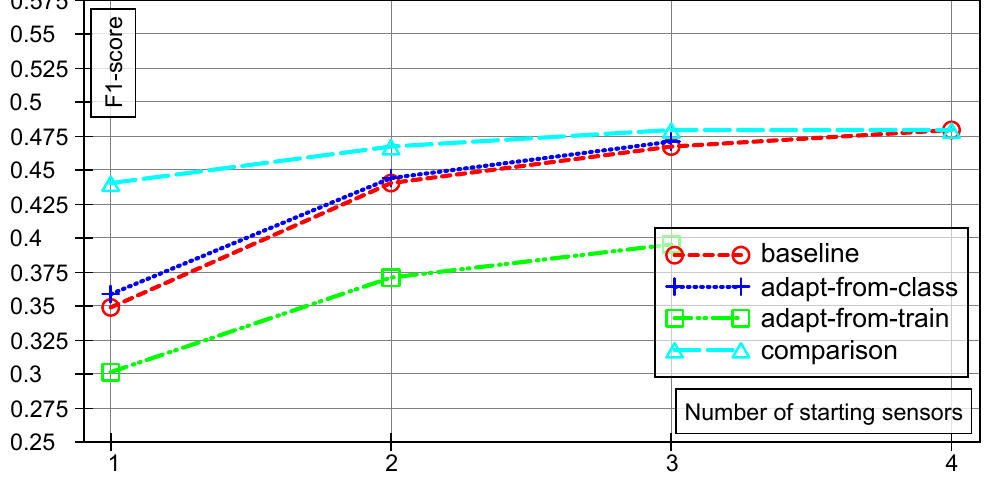
Figure 3. Test F-scores of the baseline system, the extended system with labels inferred from the training data ( adapt-from-train ), the extended system with labels inferred from the original classifier ( adapt-from-class ) and of the comparison system ( comparison ), for different numbers of starting sensors. In each case, one additional sensor is added to the